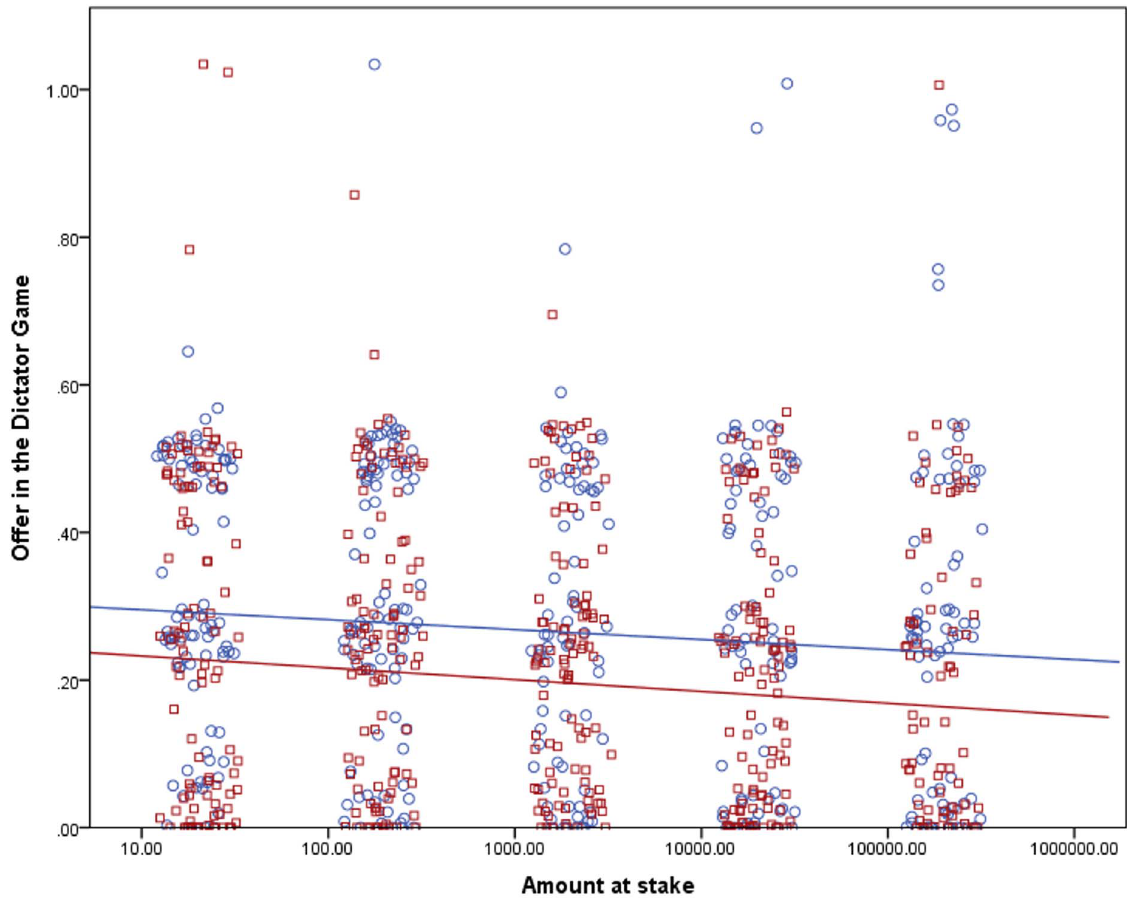
Figure 1. Effect of the amount at stake on the relative proposed shares in the DG. The stakes are shown on a logarithmic scale and are in CZK. The points were jittered to be better visible in their numbers. Treatment One, where the subjects only answered questions for one amount at stake, is marked with circles and the color of the points and the regression line is blue. The estimated effect size for the influence of the stakes on the shares in Treatment One is 0.8%. Treatment Five, where the subjects answered questions for all five amounts, is marked with squares and it has red points and the regression line. The estimated effect size for the influence of the stakes on the shares in Treatment Five is 1.2%. doi:10.1371/journal.pone.0060966.g001 PLOS ONE |